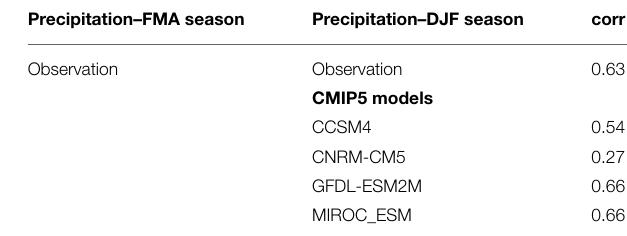
TABLE 3 | Lagged correlation between the normalized daily precipitation time series derived from the CMIP5 models for the DJF season and observed for the FMA season during the 1963–2003 period.